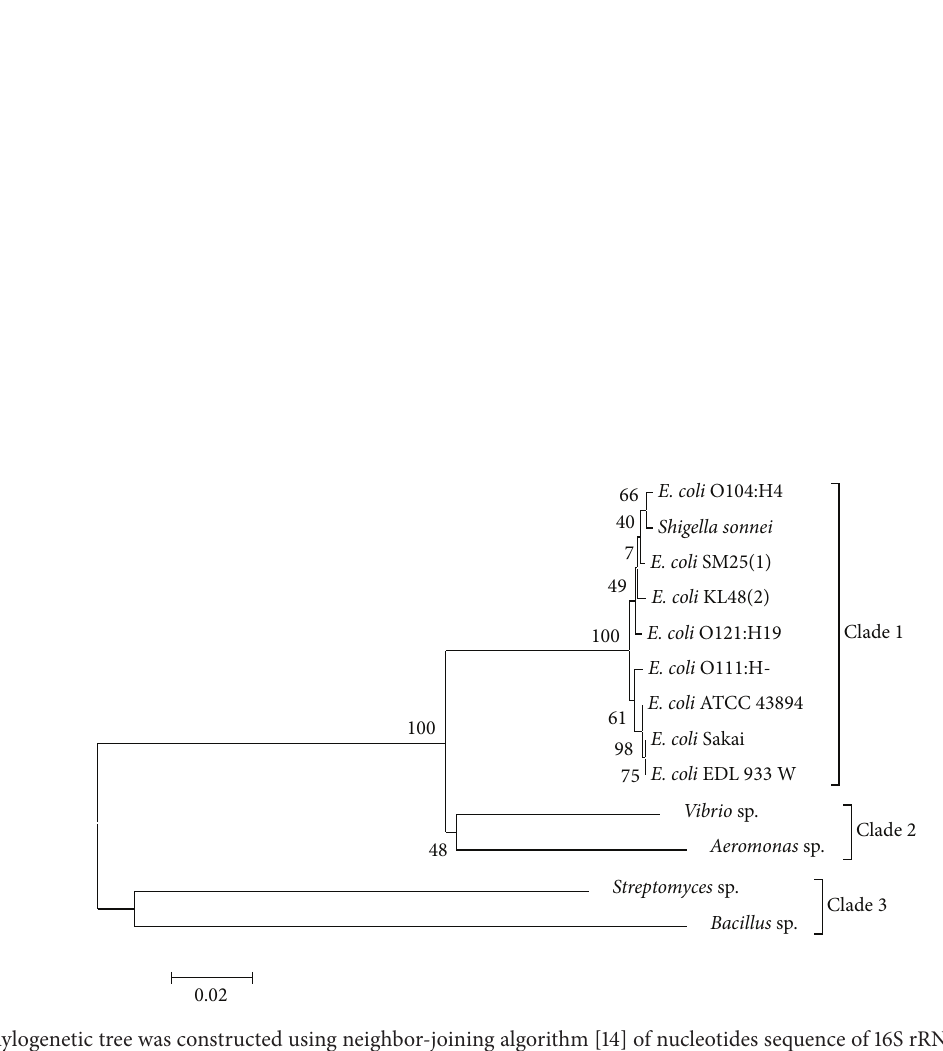
Figure 2: Phylogenetic tree was constructed using neighbor-joining algorithm [14] of nucleotides sequence of 16S rRNA gene. The number in the branch of phylogram indicates bootstrap value (%) by 1000-replication multiple and scale indicates one per 1000 substitutions of nucleotides sequence of 16S rRNA